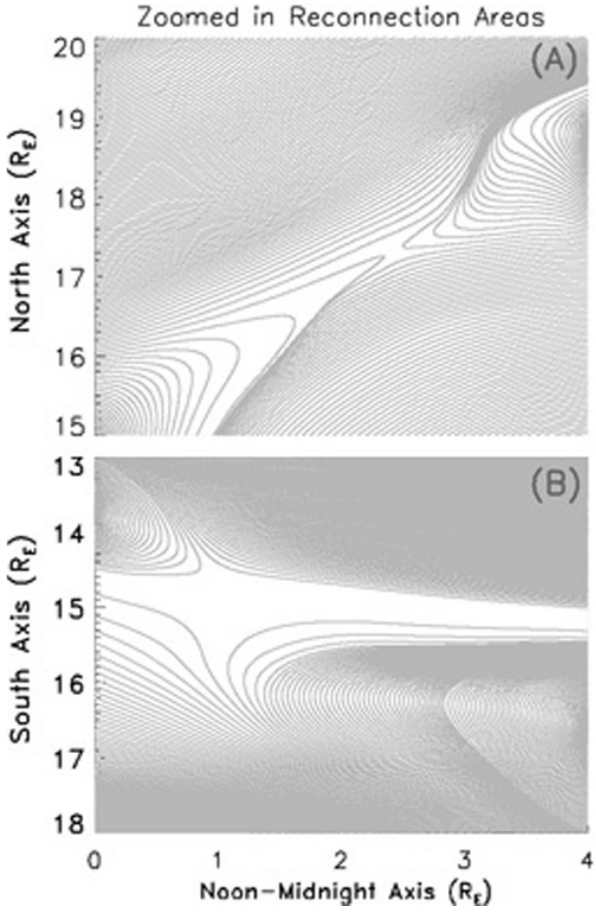
Fig. 5. Zoomed in northward and southward cusp regions showing the reconnection events between geomagnetic and magnetosheath fields as indicated in Fig. 2a. (a) For the northward cusp, the zoomed area is (0:4, 15:20) R E from Earth. (b) For the southward cusp, the area is (0:4, 13:18) R E from